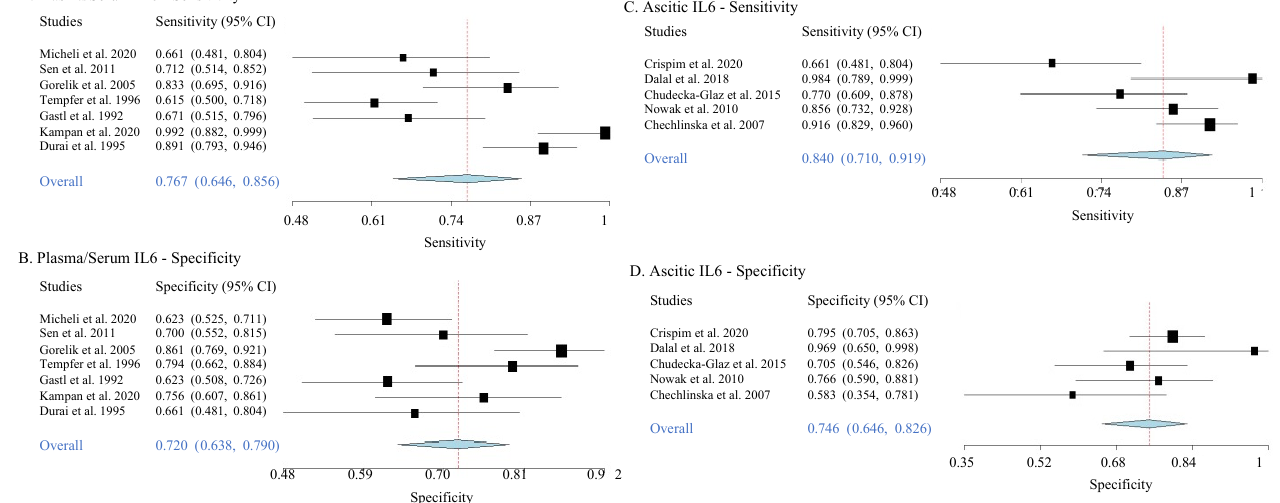
Figure 5. Forest plots of sensitivity and specificity of plasma/serum and ascitic IL6 to diagnose OC. The forest plots are generated from the sensitivity and specificity data from various studies when predicting the presence of ovarian cancer (mixed stages) from the benign controls. Each blue diamond indicates the summary of overall sensitivity or specificity from each plot.